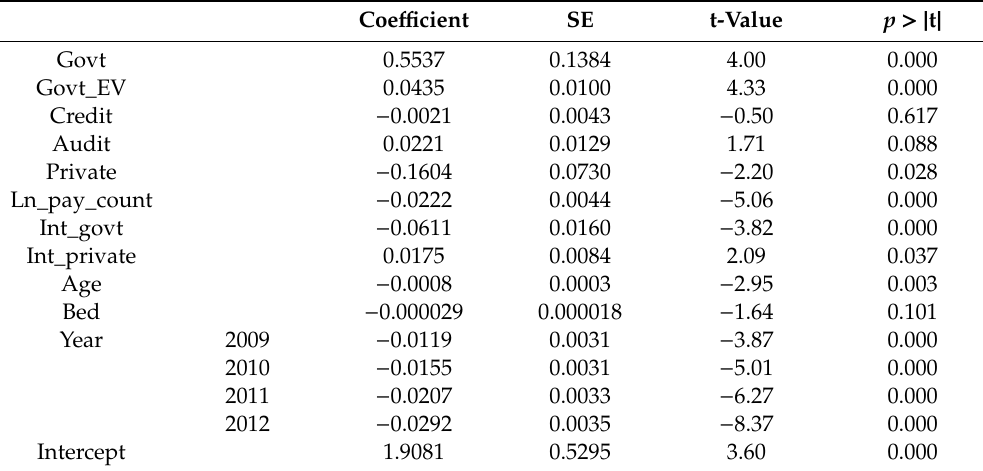
Table A7. Random e ff ects regression of publicness on overall